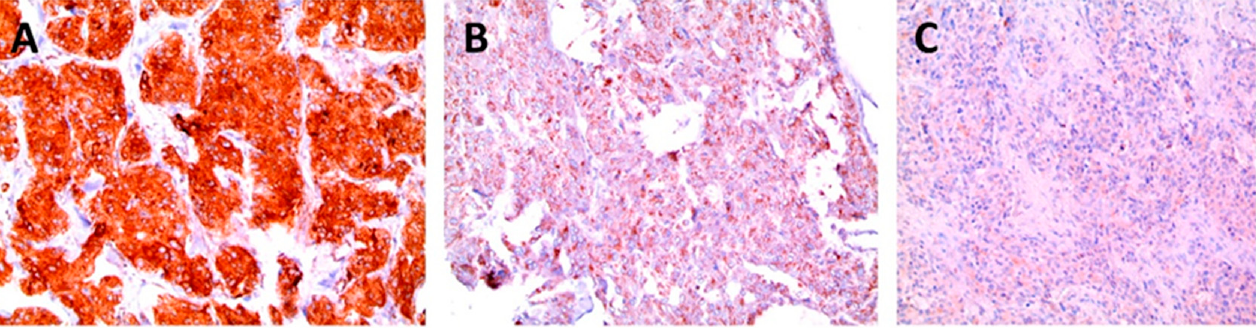
Figure 1. Positive ( A ), weakly positive ( B ), and negative ( C ) stains for Figure 1. Positive(A), weakly positive(B), and negative(C) stains for SDHB.